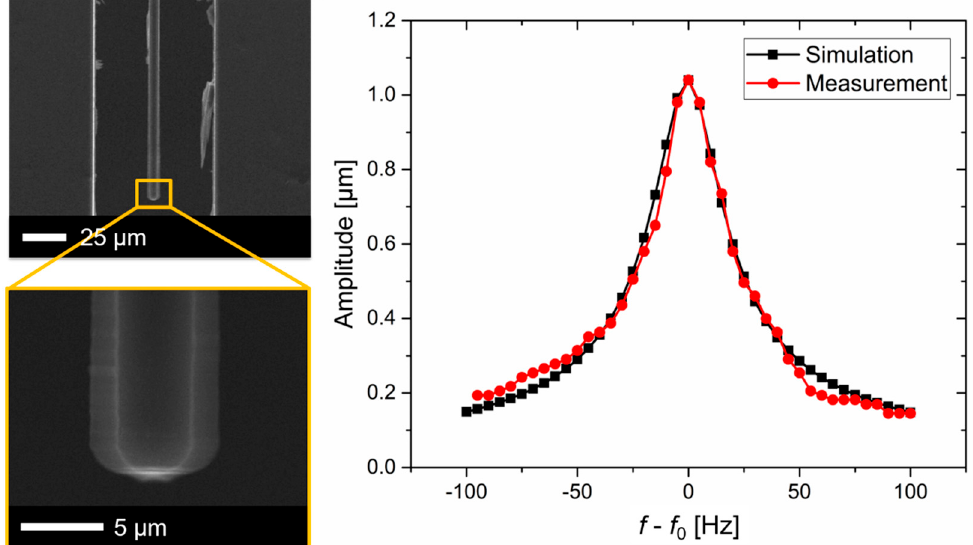
Figure 6. Top-view SEM images of a fabricated Si cantilever excited in in-plane ( left ) with measured and simulated displacements around the resonance frequency ( right ).